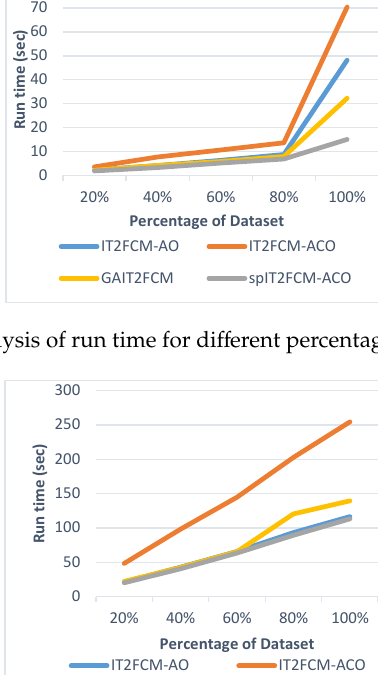
Figure 9. Analysis of run time for different percentages of poker dataset. Sensors 2020 , 20 , x FOR PEER REVIEW